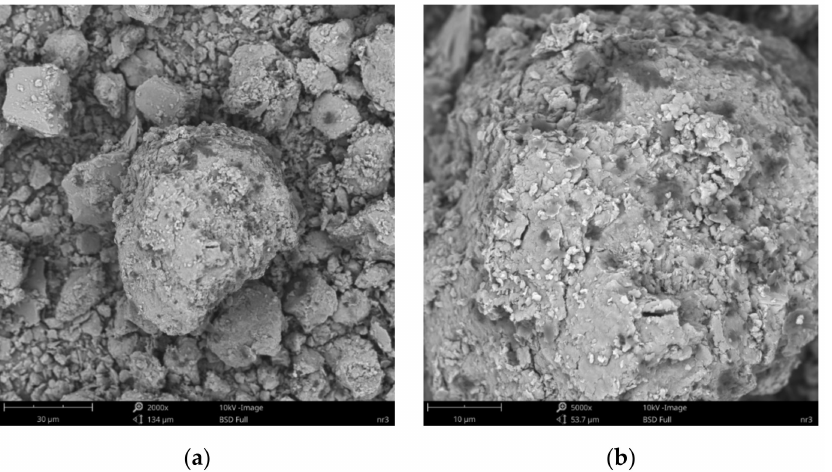
Figure 9. SEM images of particle surfaces for ( a ) SN/25PAA, magnification: 2000 × , scale bar: 30 µ m;